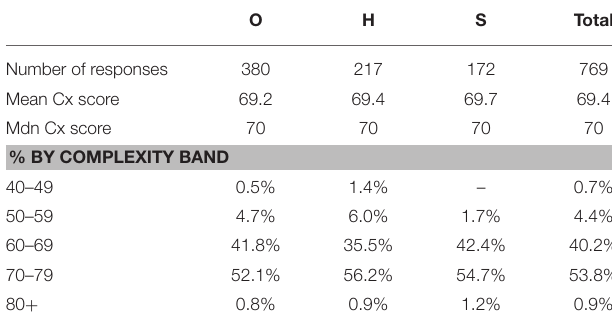
TABLE 7 | Occupation complexity score (Cx) by expertise